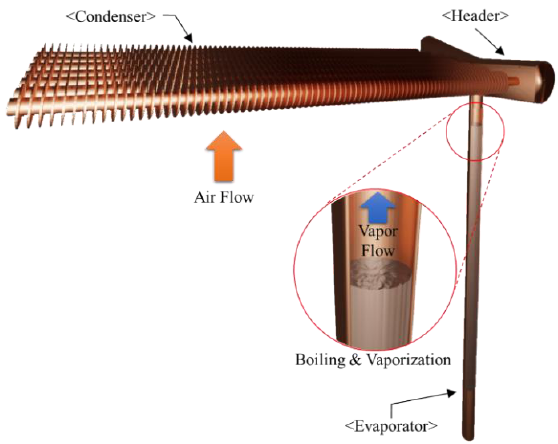
Figure 2. Conceptual drawing of a fork-type heat pipe (FHP).